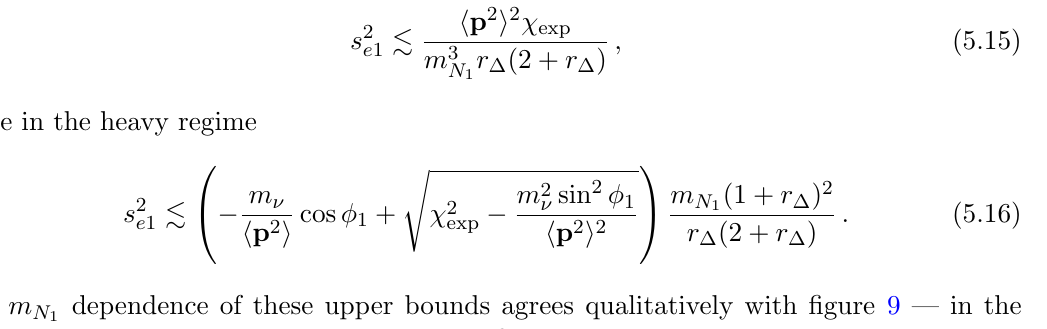
. 50 GeV for r & 10 (cid:0) 10 (cid:1) 1